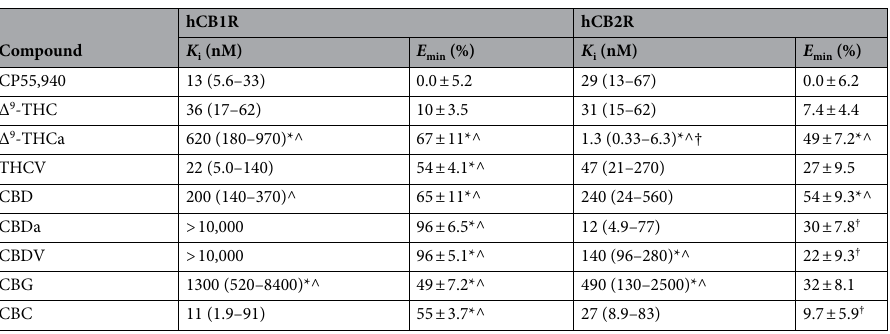
Table 1. [ 3 H]CP55,940 displacement from hCB1R or hCB2R CHO cell membranes. Compound activity was quantified for [ 3 H]CP55,940 binding in CHO cells stably expressing hCB1R or hCB2R and treated with compounds. Data were fit to a variable slope (4 parameter) non-linear regression in GraphPad (v. 8). n ≥ 6 independent experiments performed in duplicate. E Min refers to the bottom of the concentration– response curve. Data are expressed as nM with 95% CI or %CP55,940 response, mean ± SEM. *p < 0.05 compared to CP55,940 within receptor; ^p < 0.05 compared to ∆ 9 -THC within receptor; †p < 0.05 between receptors; as determined via non-overlapping 95% CI or one-way ANOVA followed by Tukey’s post-hoc test. Corresponding graphs are presented in Figs. 2 and 5.